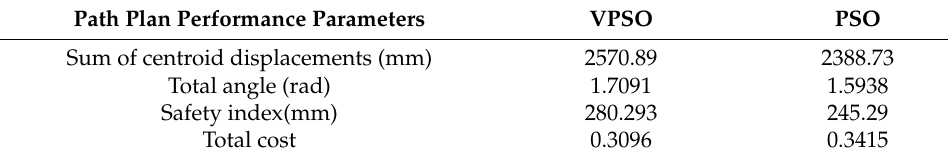
Table 5. Simulation parameters of the point-searching algorithm.